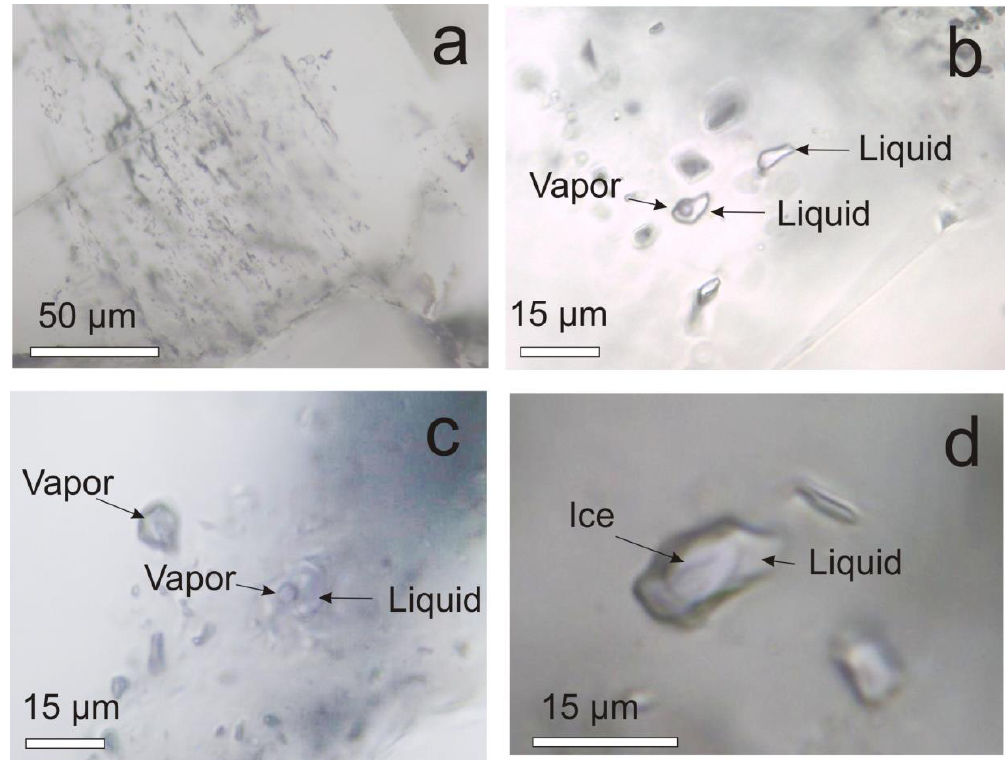
Figure 17. Fluid inclusions in crystalline quartz: ( a ) a fragment of the growth zone traced by fluid inclusions, ( b ) two-phase and single-phase water-salt inclusions, ( c ) single-phase gas and two-phase water-salt inclusions, ( d ) single-phase water-salt inclusions at a temperature of − 10 °С, the frozen -out phase of ice is visible, which finally melts at − 0.3 °С .